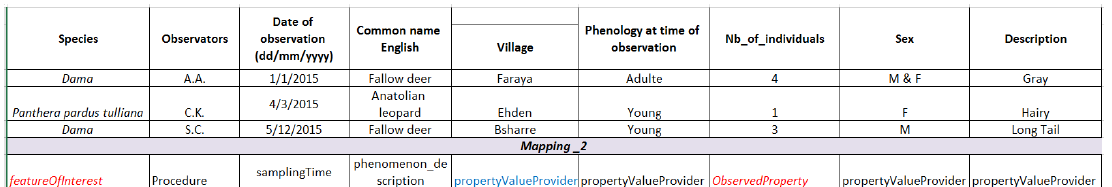
Figure 6. Running example: mapping on the species.